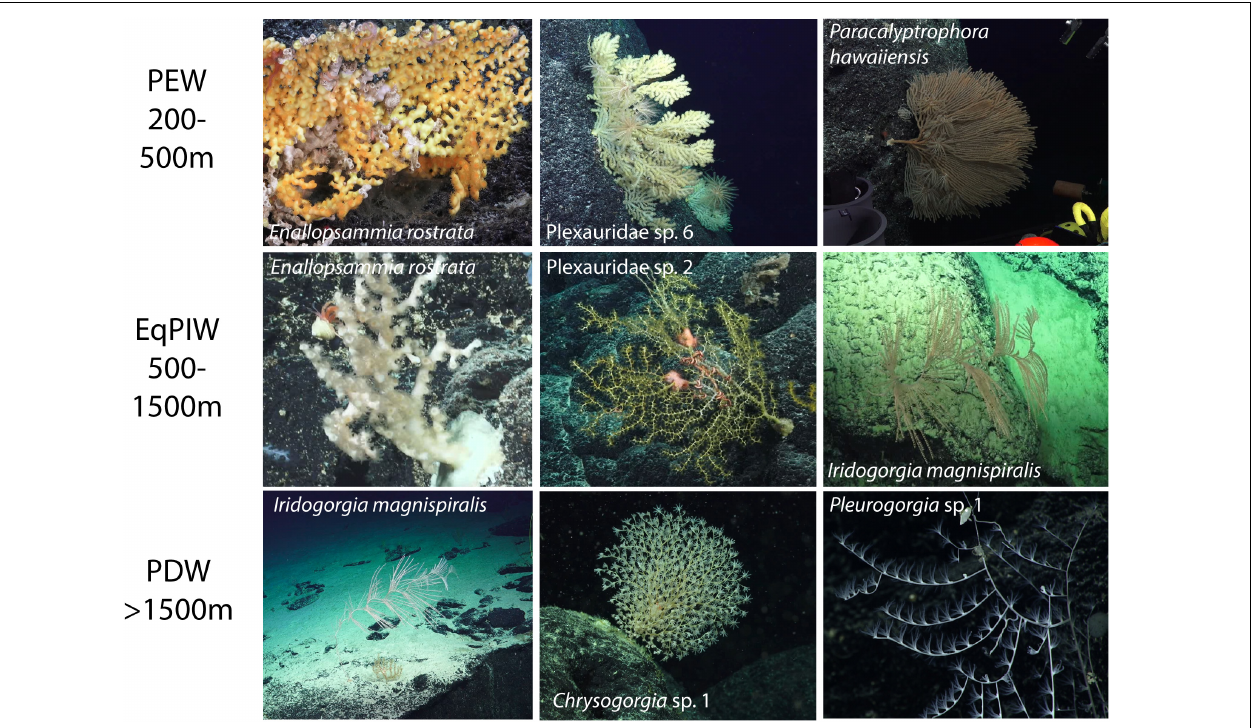
FIGURE 8 | Top 3 morphospecies with disproportionate influence on coral assemblage similarity within each water mass as a result of the SIMPER analysis. Morphospecies on the far left are the largest contributors to within-water mass similarity with influence rank decreasing toward the right.